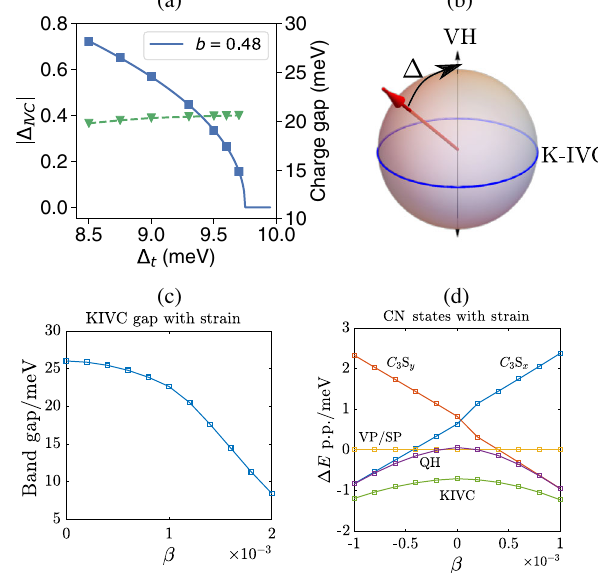
FIG. 7. (a) K-IVC order parameter as a function of the sublattice potential Δ on the top layer (blue) fitted to t − Δ 10 . 35 meV, with the gap across b with Δ a ð Δ t; (cid:4) Þ t; (cid:4) ¼ IVC the transition shown in green. The curve was computed on a 12 × 12 momentum grid using the parameters θ ¼ 1 . 05 °, w 0 ¼ 80 meV, w 1 ¼ 98 meV, and ϵ ¼ 12 . (b) Schematic illus- tration of the manifold of low-energy states for finite Δ . Since the IVC and VH order parameters anticommute, the order parameter is a vector on S 2 that gradually rotates towards the z axis as Δ is t increased. (c) IVC gap as a function of the C 3 -breaking parameter β , with the energies of the different states as a function of β given in panel